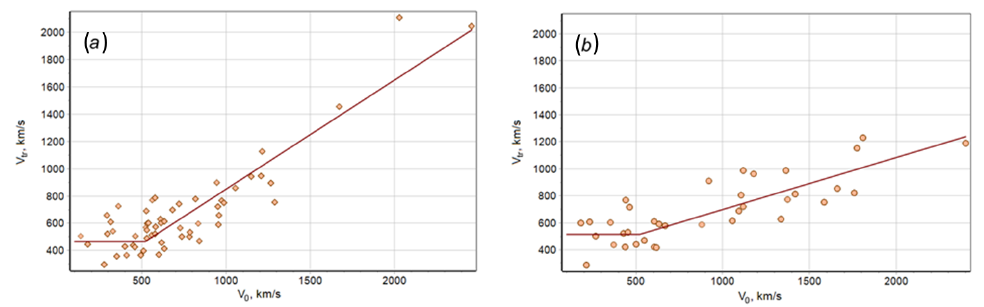
Figure 3. Dependence of the ICME transit speed on the parent CME initial speed for events with absolute heliolongitude: ( a ) φ ≤ 8 ◦ ; ( b ) 15 ◦ ≤ φ ≤ 24 ◦